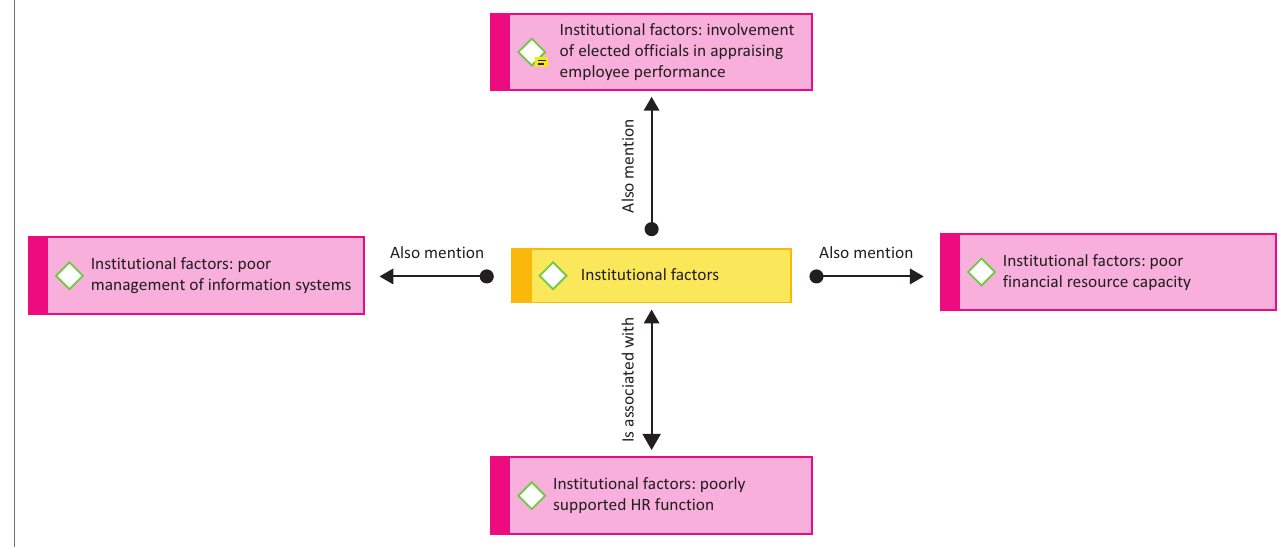
FIGURE 2: Code network for the theme institutional factors. HR, human